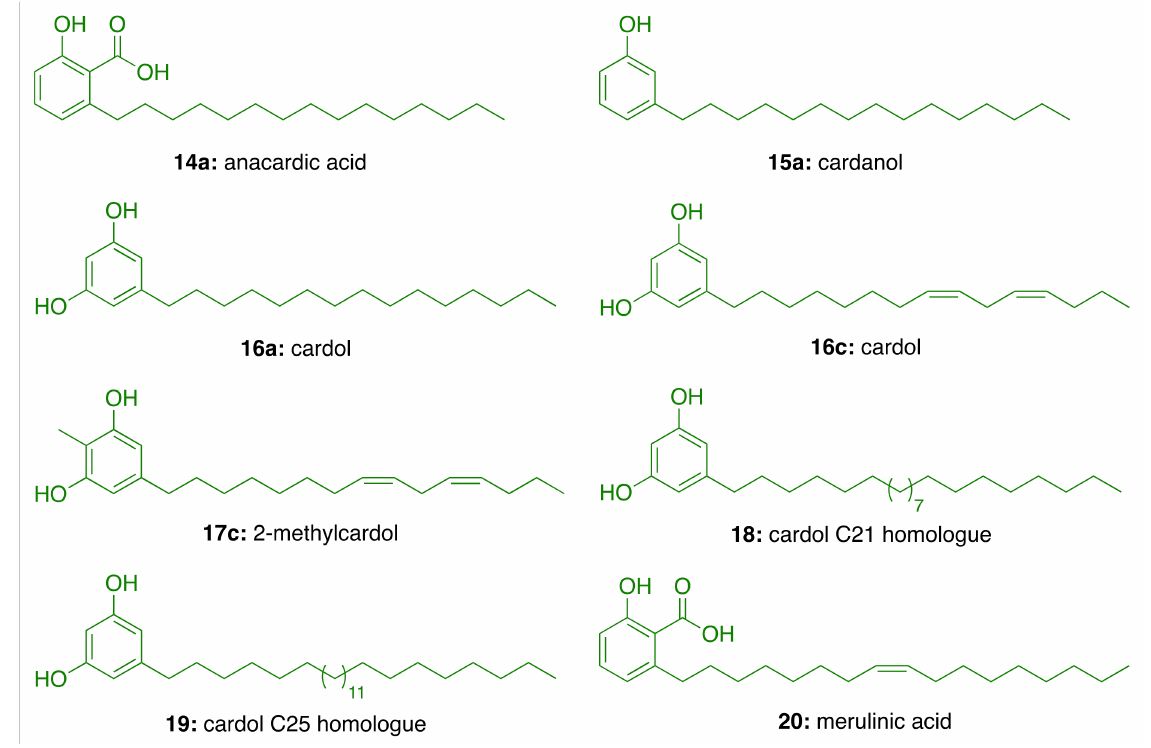
Figure 5. Phenolic lipids from A. occidentale , rye grain, and M. tremellosus .